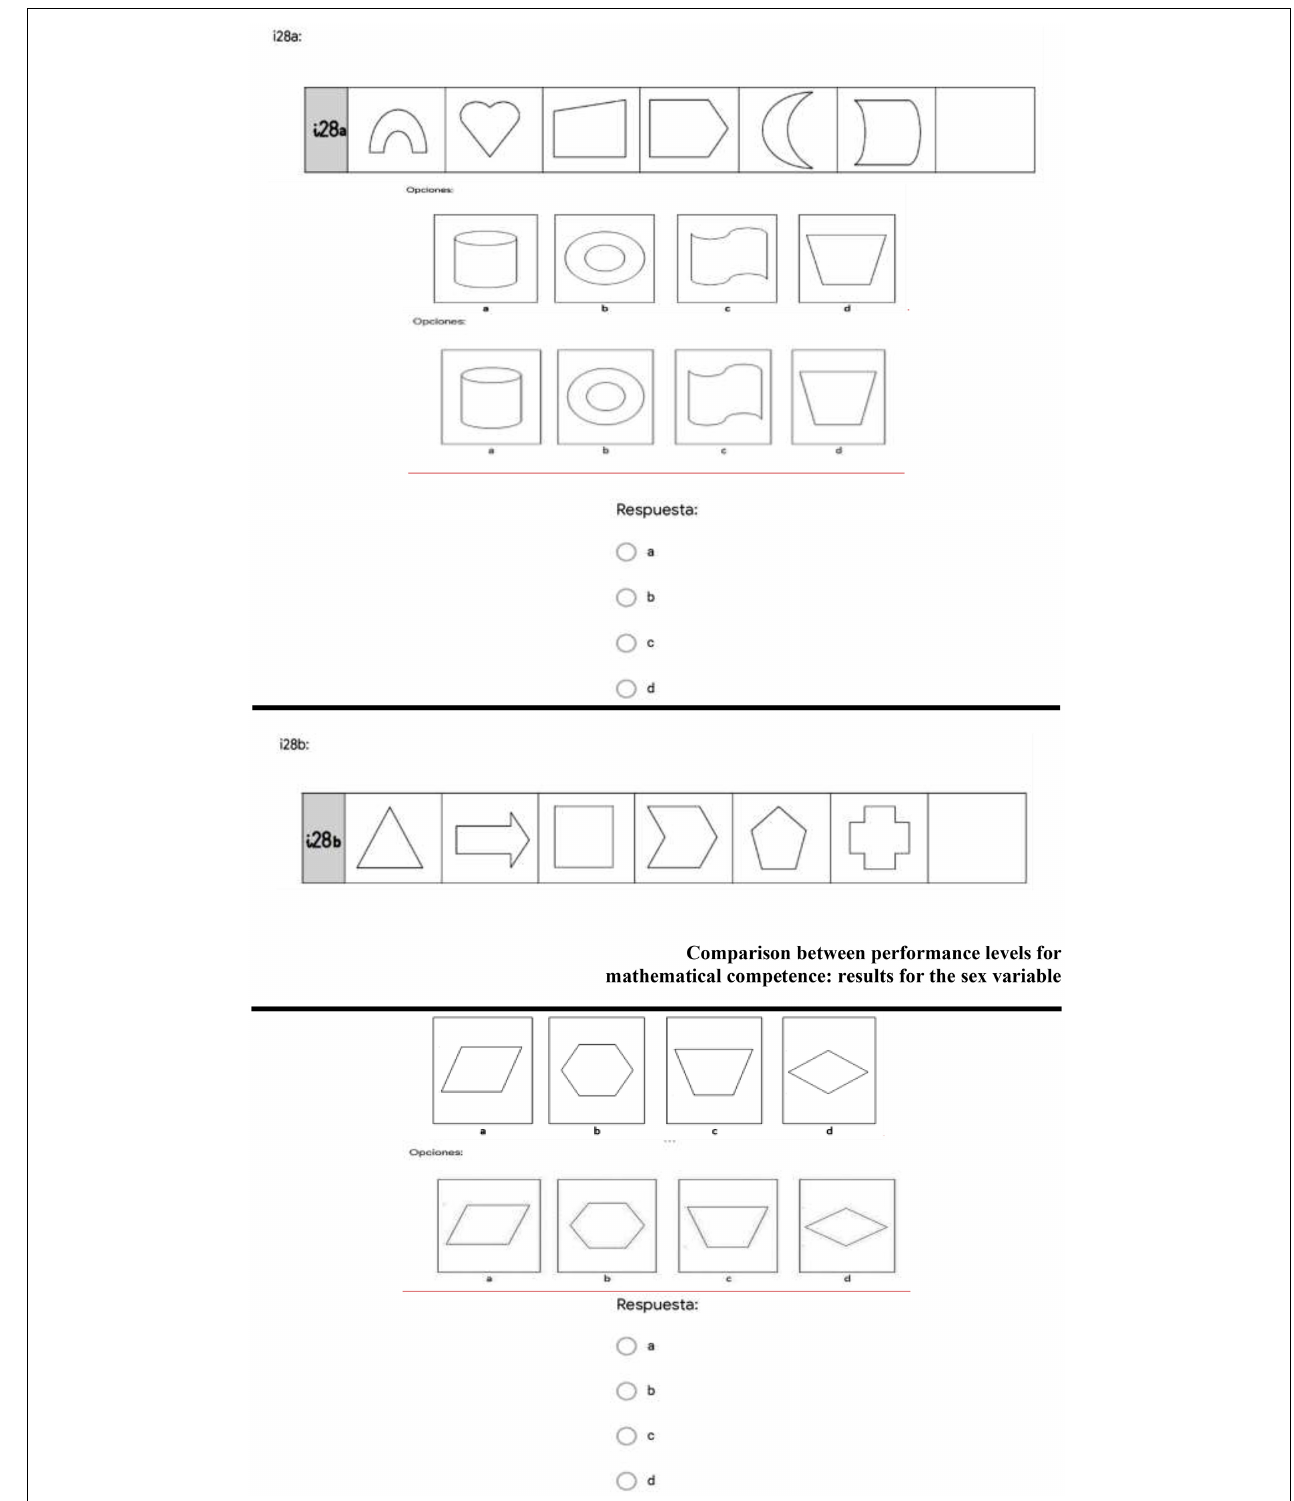
FIGURE 3 | Item 28, the most difficult item in the instrument in this study. Authors’ own work (2020).